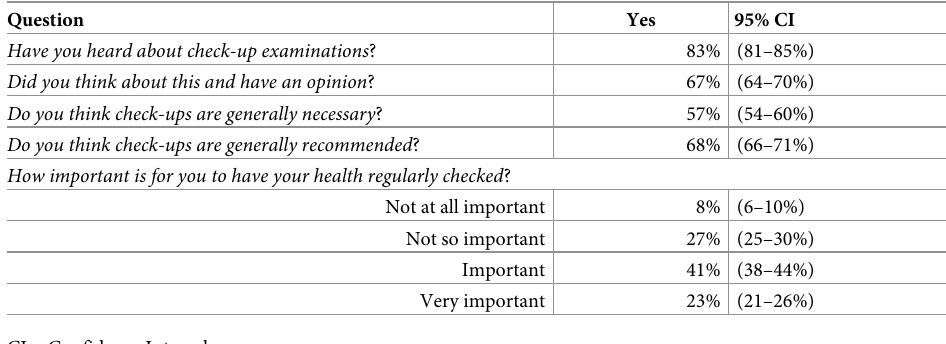
Table 2. Opinion variables descriptives in proportion (n =